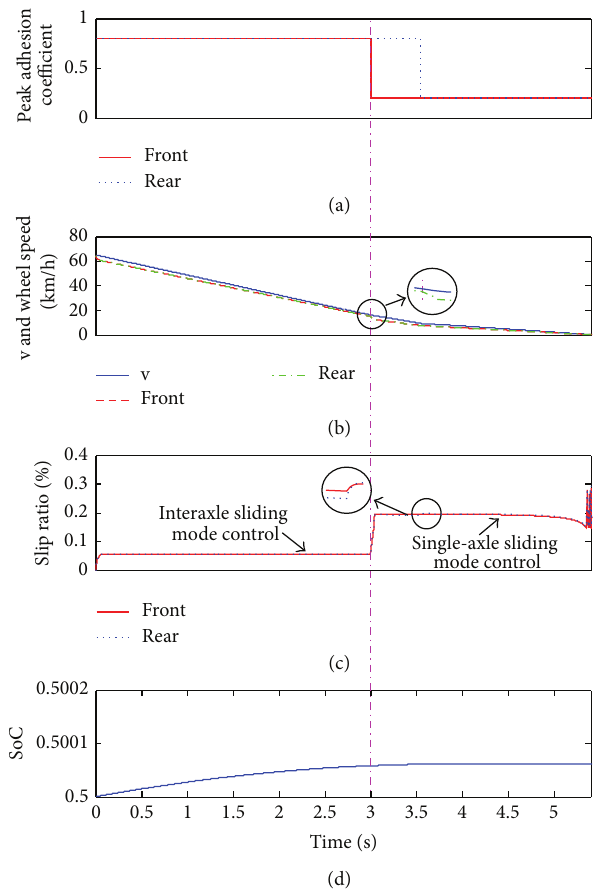
Figure10: Thesimulationresultswhen passingthecomplex surface.